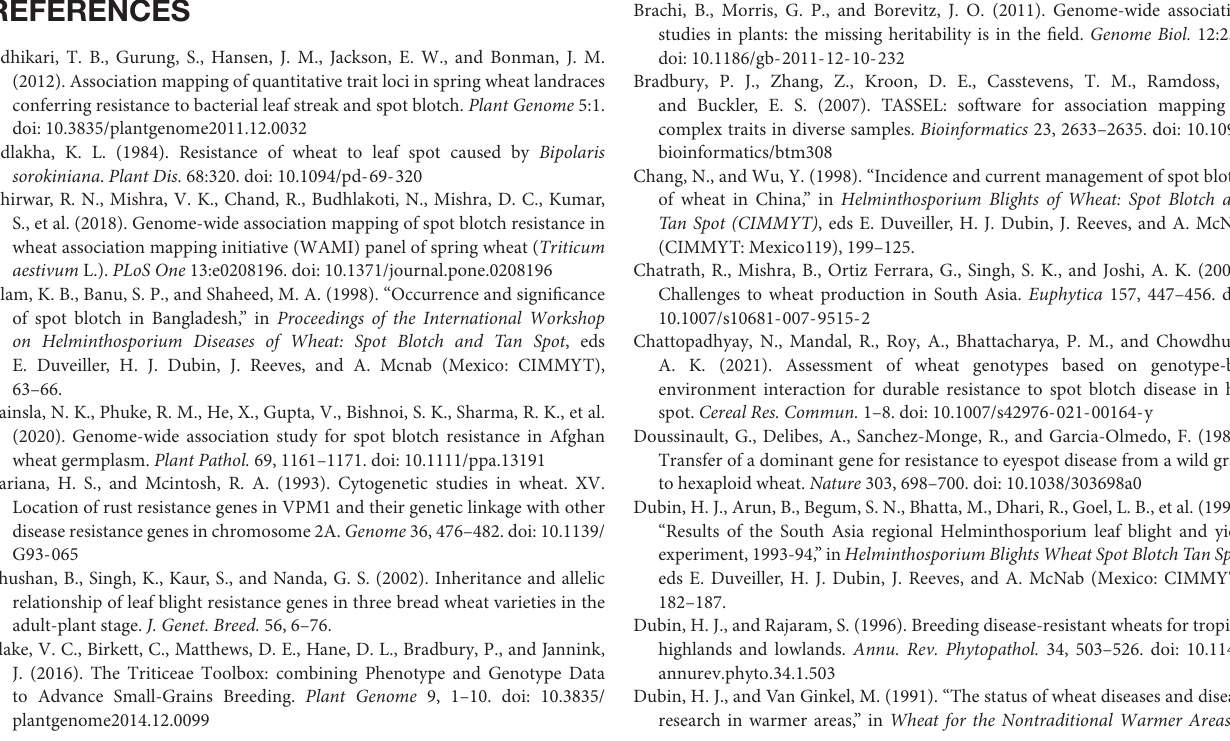
Supplementary Figure 8 | Linkage disequilibrium between the unaligned markers. The standardized disequilibrium coefficients ( D (cid:48) ) are shown in the lower-left matrix and correlations between alleles at the two marker loci ( r 2 ) are shown in the upper-right matrix. Supplementary Figure 9 | Boxplots with the spot blotch relative area under the disease progress curve (rAUDPC) values in different panels, for lines with favorable alleles (alleles that have a decreasing effect on spot blotch) and non-favorable alleles (alleles that have an increasing effect on spot blotch) at spot blotch associated markers. The boxplots are only shown for the panels where the mean differences in rAUDPC values for the favorable and non-favorable alleles were significant. Supplementary Table 1 | Markers significantly associated with spot blotch in panels 2014, 2015, 2016, 2017, 2018, 2019, and 2020 after Bonferroni correction for multiple testing at an α level of 0.2 along with markers that were consistently associated with spot blotch in at least two panels at a p -value threshold of 0.001. The markers that were not significant after Bonferroni correction for multiple testing are indicated along with the number of panels in which the markers were significant. Supplementary Table 2 | Allelic fingerprinting of markers that were consistently associated with spot blotch in more than one panel (1 = favorable allele that has a decreasing effect on the spot blotch relative area under the disease progress curve values, 0 = non-favorable allele that has an increasing effect on the spot blotch relative area under the disease progress curve values, 0.5 = heterozygote). Supplementary Table 3 | Lines with 67–83 spot blotch favorable alleles at 96 markers that were consistently associated with spot blotch in more than one panel (1 = favorable allele that has a decreasing effect on the spot blotch relative area under the disease progress curve values, 0 = non-favorable allele that has an increasing effect on the spot blotch relative area under the disease progress curve values, 0.5 =